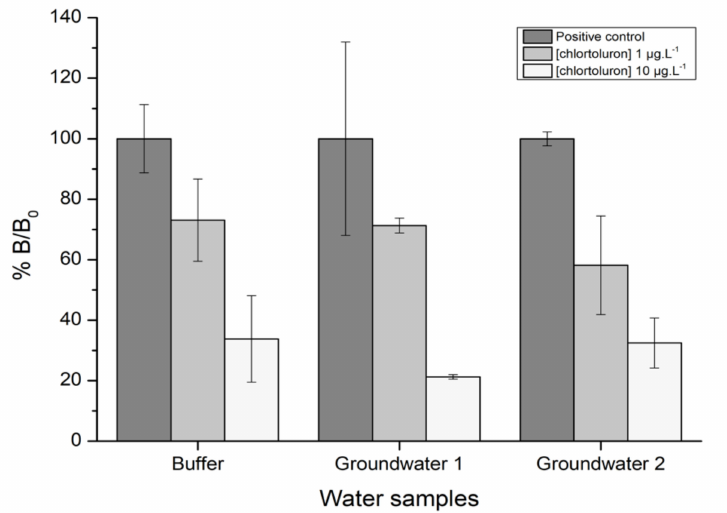
Figure 10. Electrochemical measurements of chlortoluron diluted at 1 and 10 µ g · L − 1 in two ground- waters and in the reference buffer PBS 1 × pH 7.4.